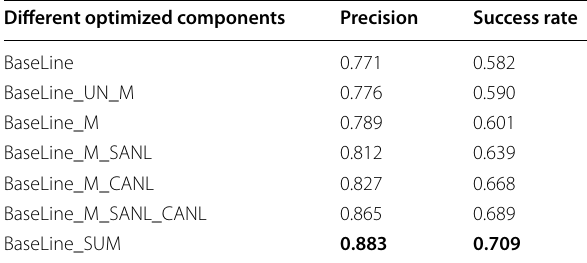
Table 1 Comparison of different optimized components of SiamANAL algorithm on OTB100